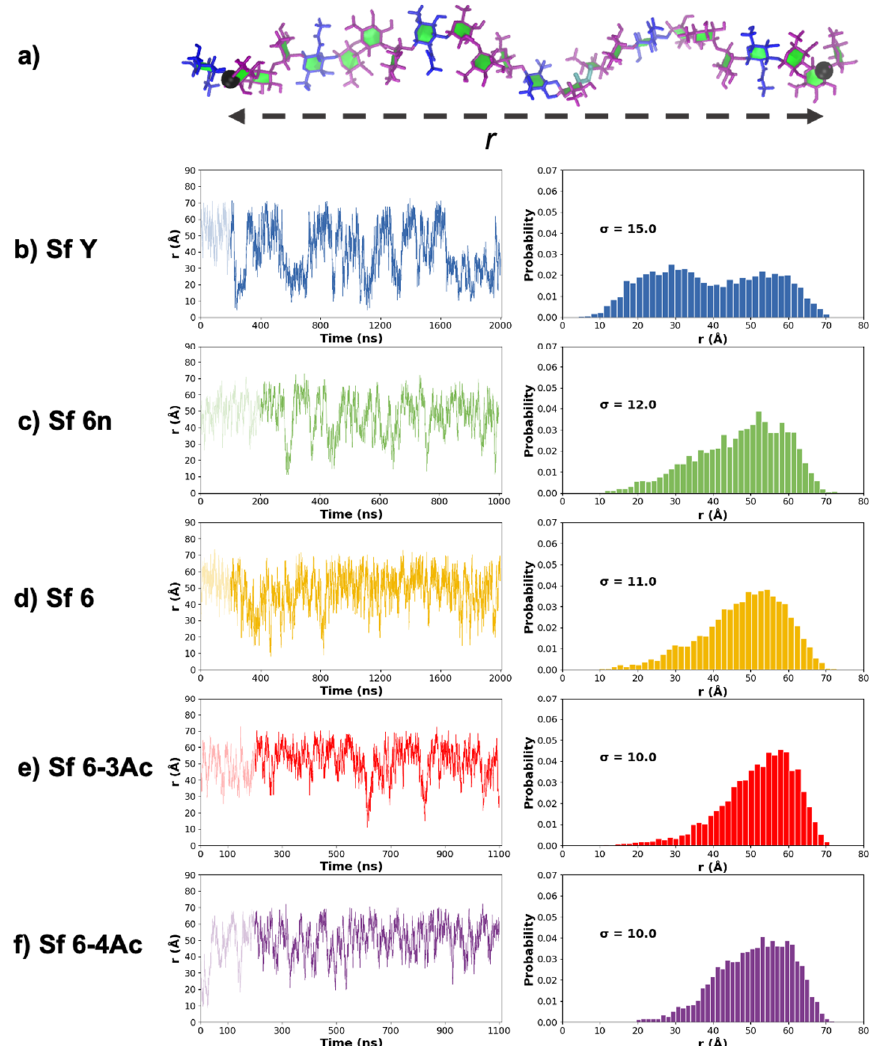
Figure 2. End-to-end distance, r , is defined as shown in ( a ) with end-to-end distance time series as well as histograms shown for O-Ags ( b ) Sf Y, ( c ) Sf 6n, ( d ) Sf 6, ( e ) Sf 6-3Ac, and ( f ) Sf 6-4Ac. The standard deviation of each histogram, σ, is shown.